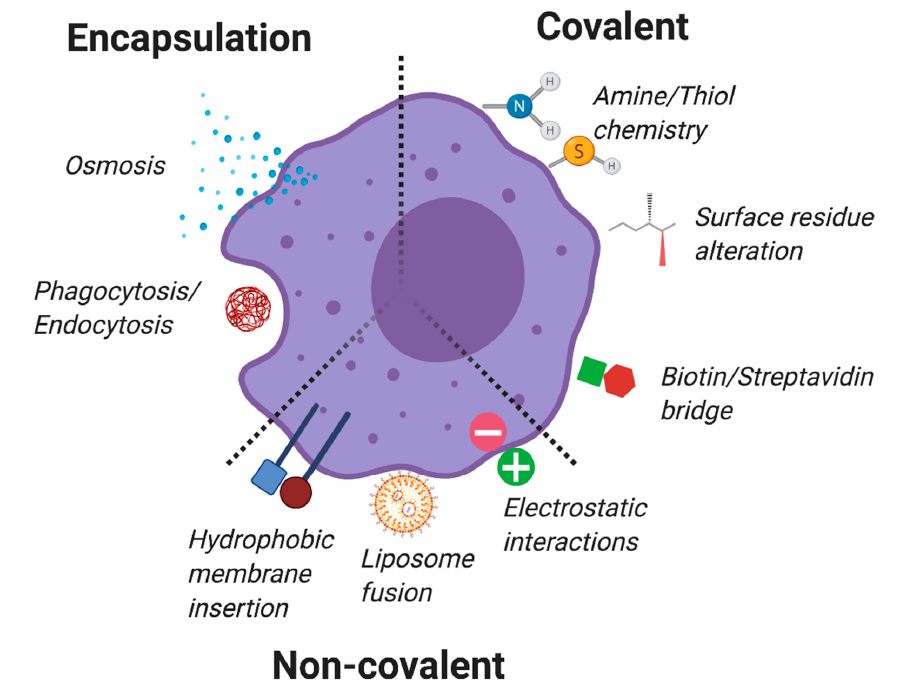
Figure 3. Non-genetic engineering of TCMs.